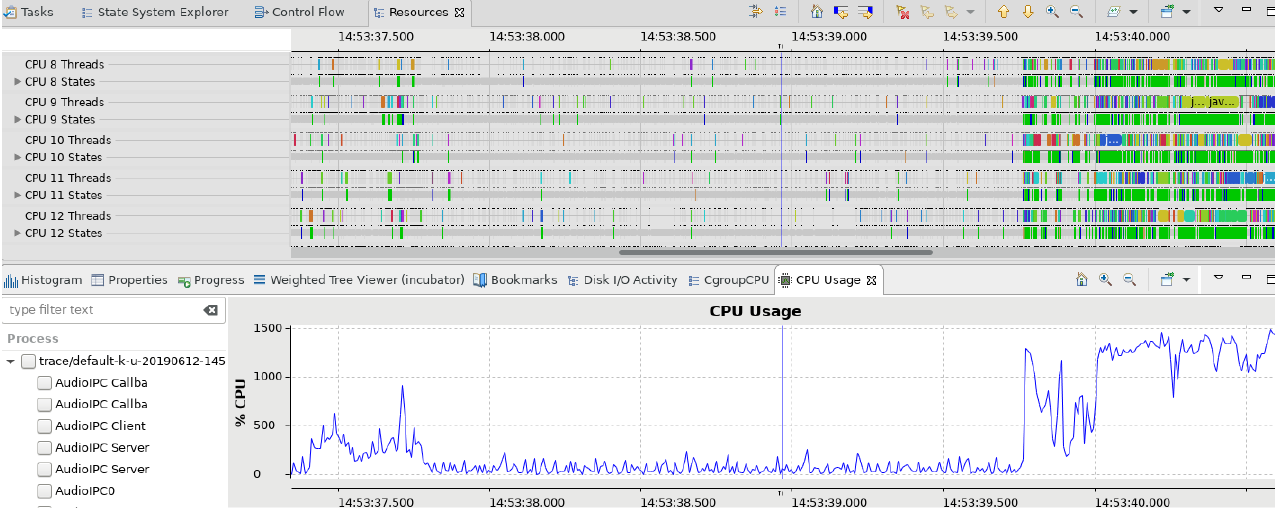
Figure 14. Use case: sub-optimal usage of the CPU. Heavy CPU limit can lead to the machine being underused. Once the CPU limit is waived, the usage is back to